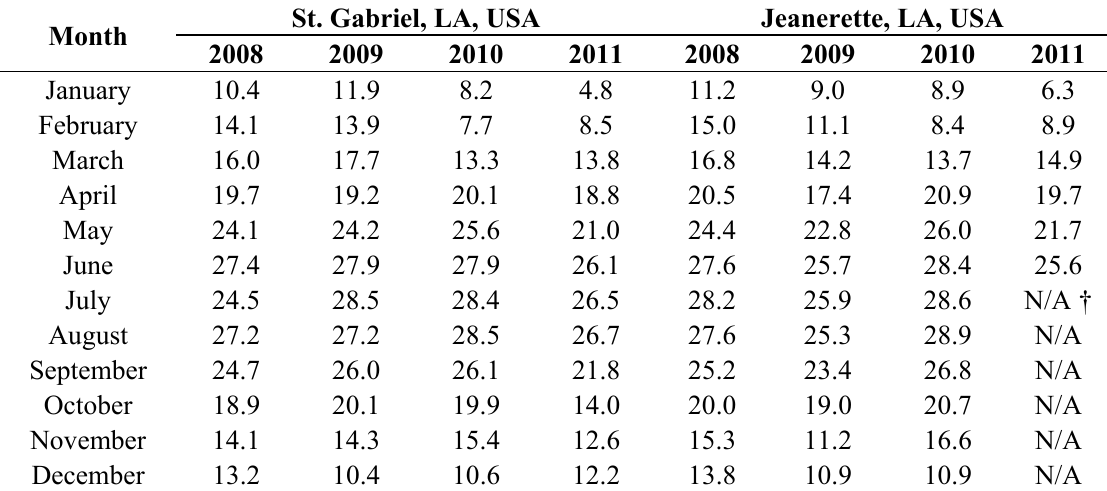
Table 1. Average monthly temperature (°C) observed in 2008–2011 for St. Gabriel and Jeanerette, LA.